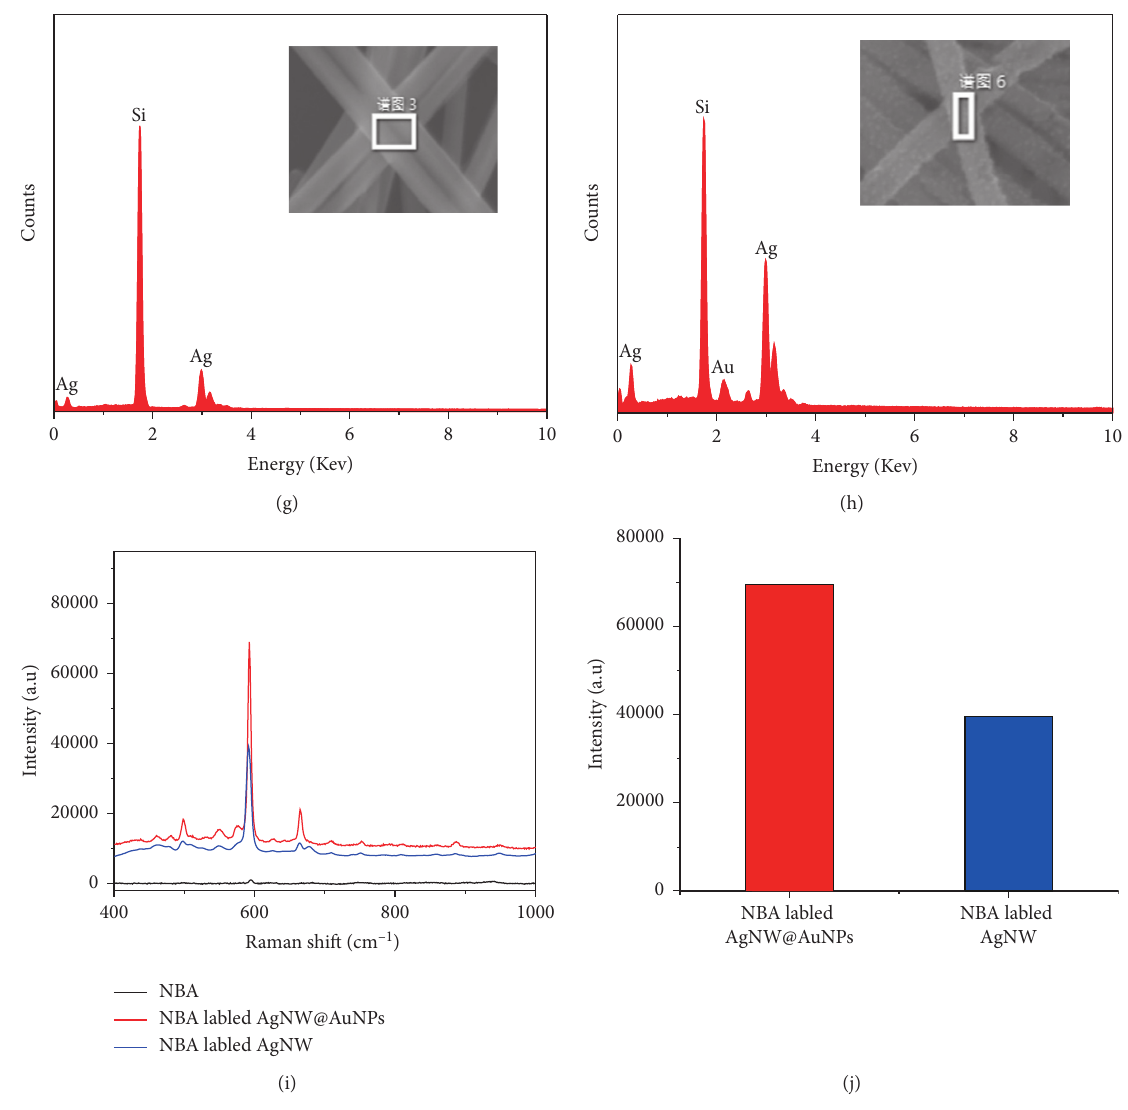
Figure 2: The images of (a) SEM and (b) TEM of the AgNW. (c) SEM images and (d) TEM images of the AgNW@AuNPs. EDX mapping of (e) Ag element and (f) Au element in AgNW@AuNPs. EDX spectrum of (g) AgNW and (h) AgNW@AuNPs. (i) SERS spectra of NBA, NBA- labeled AgNW, and NBA-labeled AgNW@AuNPs. (j) The intensity of the peaks at 592 cm − 1 corresponding to the SERS spectra in